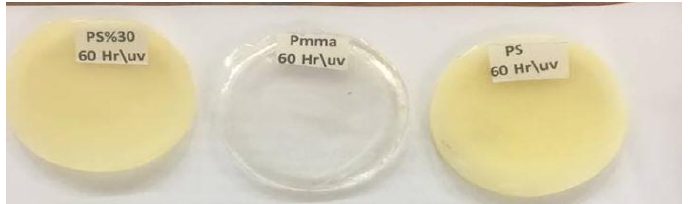
Fig.4: shows 60hr uv for PMMA, PS, 30%PMMA\PS.